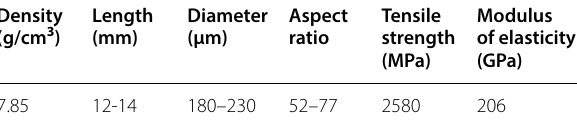
Table 3 Physical properties of micro steel